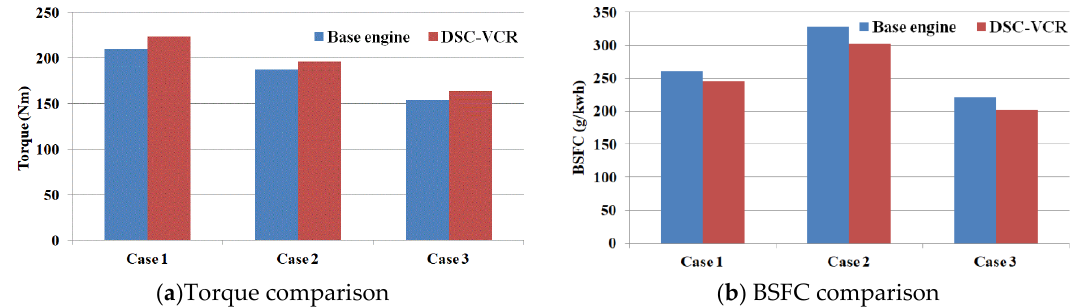
Figure 14. Comparison of torque and the BSFC for the base engine and the DSC-VCR.